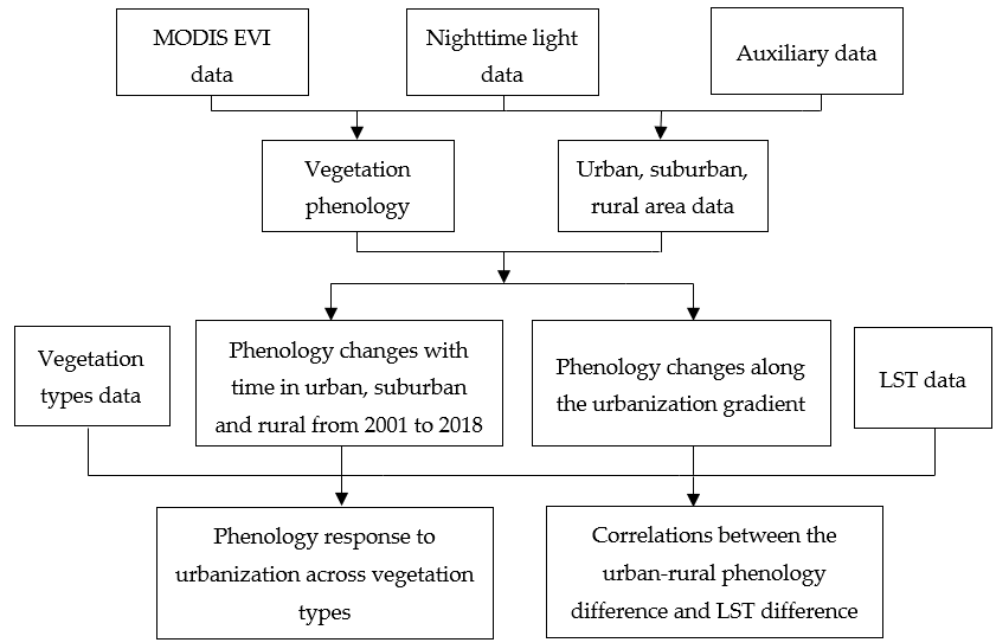
Figure 3. The flow chart of the method used in this study.